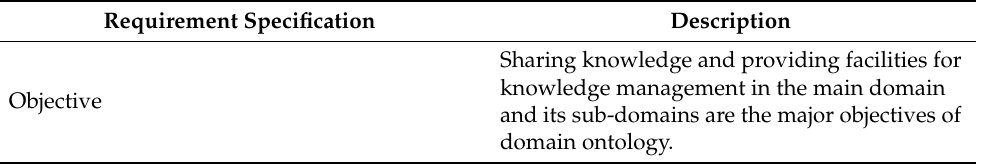
Table 2. A set of some general competency